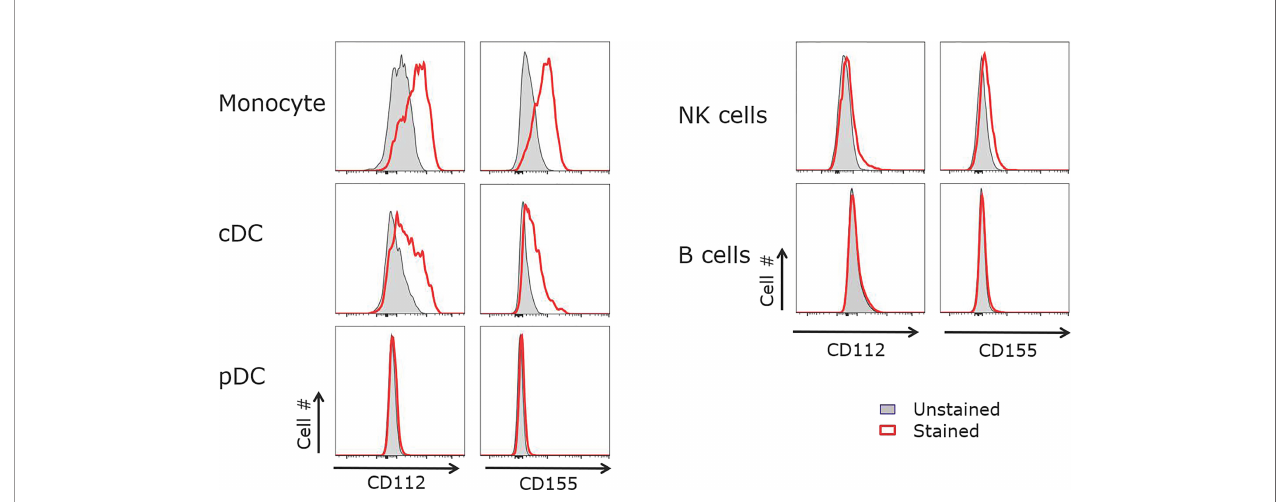
FIGURE 4 | CD155 and CD112 are expressed by monocytes and cDCs but not B cells. Tonsillar APCs were analyzed for CD155 and CD112 expression. Monocytes were de fi ned as CD3 - CD19 - CD14 + , cDCs as CD3 - CD19 - MHCII + CD11c + , pDCs as CD3 - CD19 - MHCII + CD123 + , NK cells as CD3 - CD19 - , and B cells as CD3 - CD56 - CD19 + . Representative data out of 5 experiments.